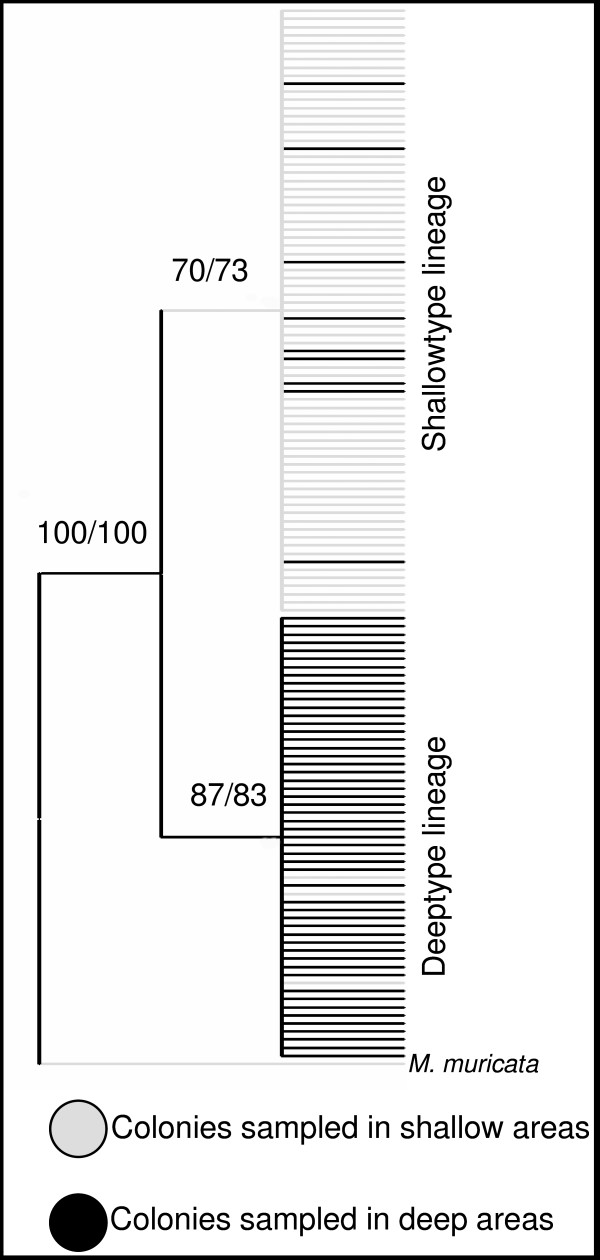
Gene genealogy for msh1. Bootstrap values for 100 and 1000 replicates in maximum likelihood and neighbor joining analyses are shown. Similar topologies and bootstrap values were recovered using maximum parsimony but not shown. Muricea muricata was used as an outgroup. In grey are colonies sampled in shallow areas and in black colonies in deep areas. The genealogy divided the individuals in two clades, which are highly indicative of the habitat origin (shallow or deep). In one clade (bottom) most of the colonies (62) are from deep areas (black), however 9 colonies (grey) fall within this clade. These 9 colonies had a different morphology despite living in the same habitat. The same pattern was observed for the top clade.